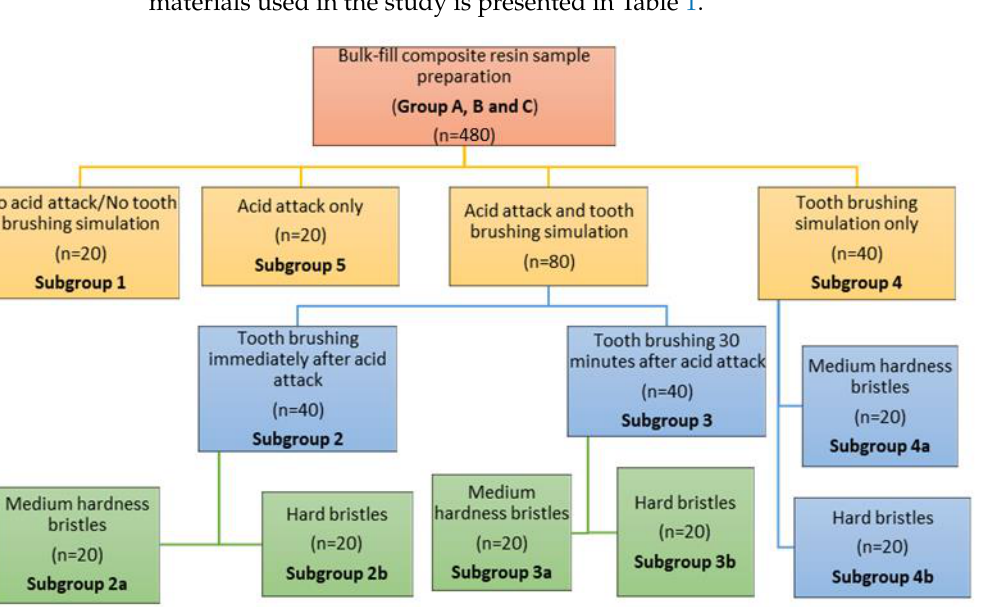
Figure 1. Design of the